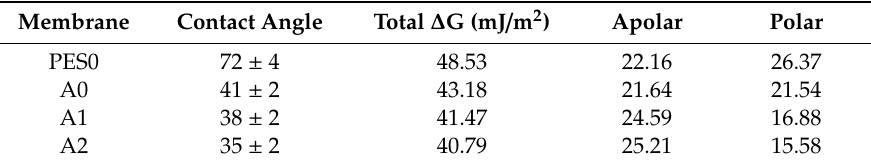
Table 3. Contact angle, surface tension, and surface free energy measurements for the membranes before and after the inclusion of the